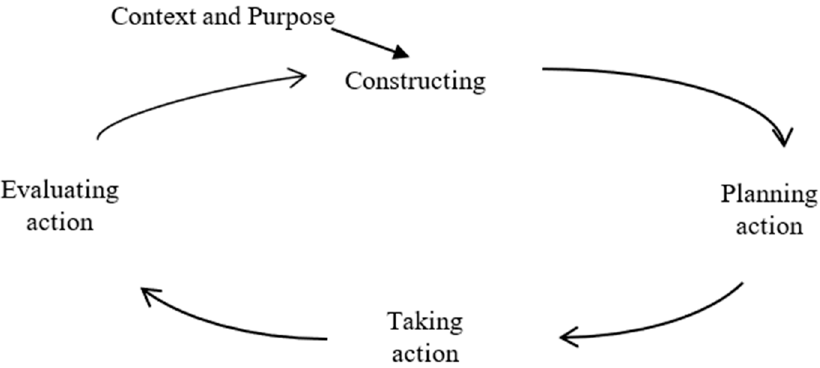
Figure 1. The action research cycle.